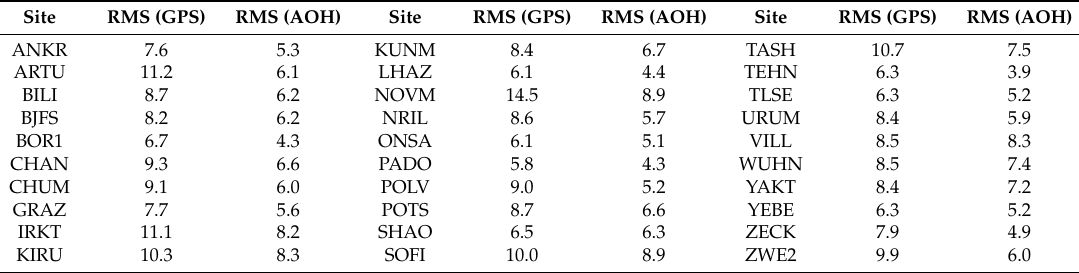
Table 2. The RMS value of GPS height time series and AOH deformation time series respectively.